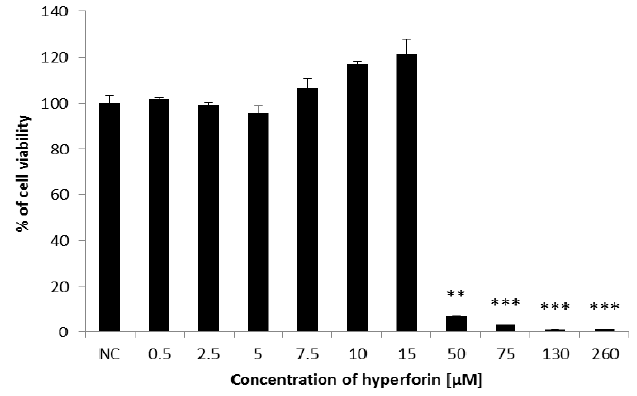
Figure 1. Determination of HF cytotoxic effects towards HepG2 cells using the MTT assay. Data shown are mean ± SD of three repeated experiments. NC = negative control. Comparison with negative control: ** 0.001 < p <0.01; *** p < 0.001.